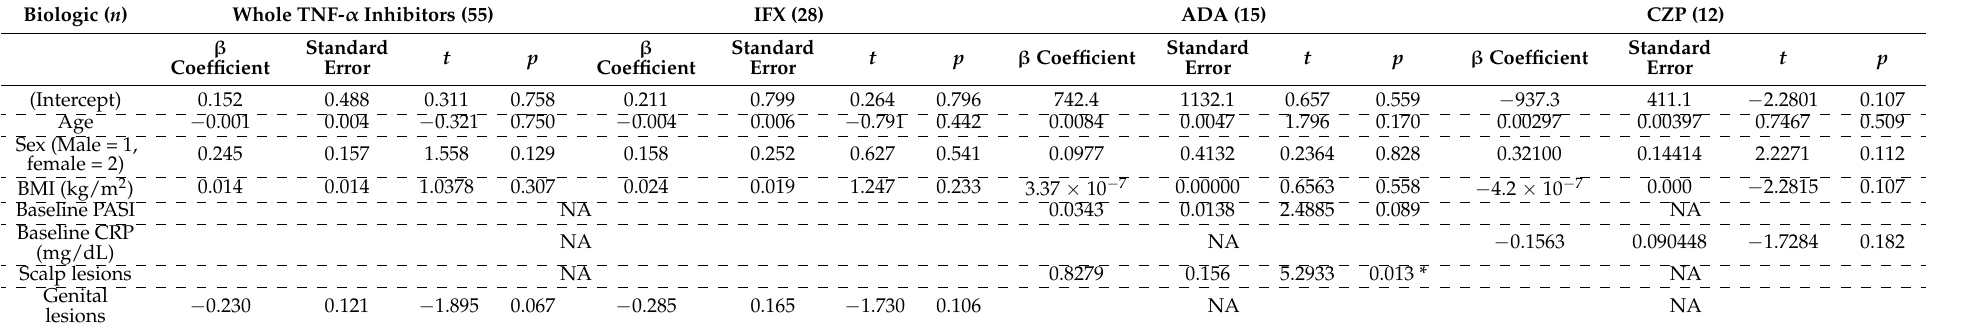
Table 9. The predictive factors for percentage reduction of psoriasis area and severity index (PASI) at week 52 analyzed using linear multivariate regression